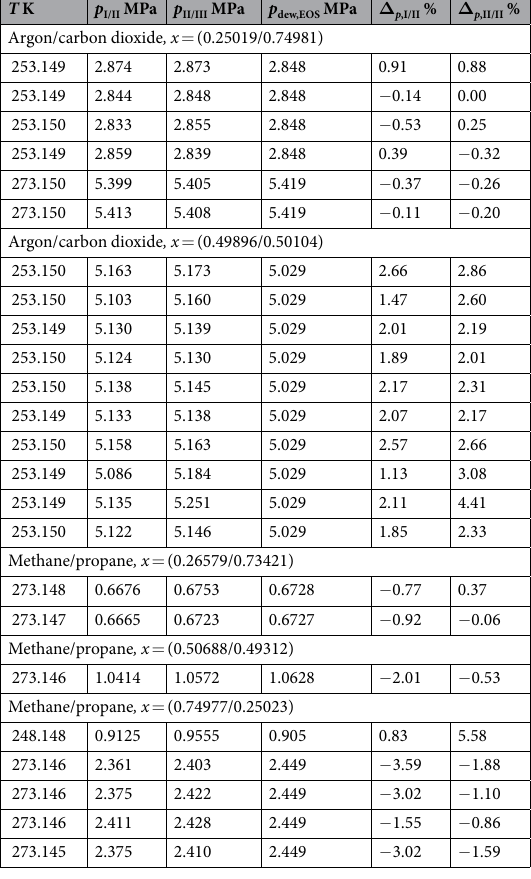
Table 1. Summary of the pressures from the isothermal experiments given by the intersection of the adsorbed mass Δ m sorption in regions I and II and the intersection of regions II and III; dew-point pressures calculated by an equation of state p dew,EOS (the EOS-CG model of Gernert and Span 12 for the argon/carbon dioxide mixtures and by the GERG model of Kunz and Wagner 13 for the methane/propane mixtures); and relative differences of the experimental intersections from the model values Δ p ,I/II and Δ p ,II/II